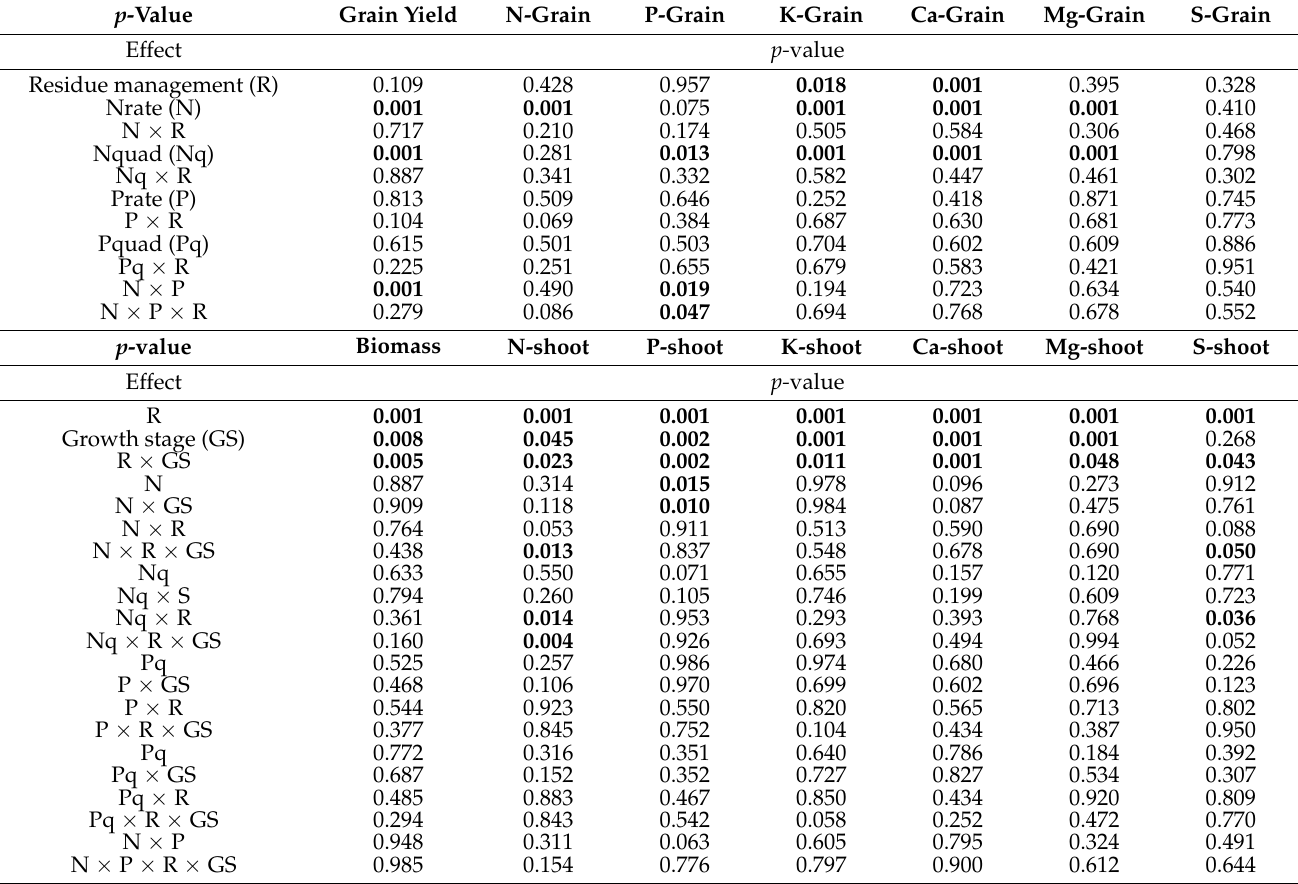
Table A3. Summary of statistical analysis for grain yield; grain N, P, K, Ca, Mg, and S accumulation; biomass accumulation; biomass N, P, K, Ca, Mg, and S accumulation in 2015 as a function of residue management, growth stage, and N and P 2 O 5 application rates.